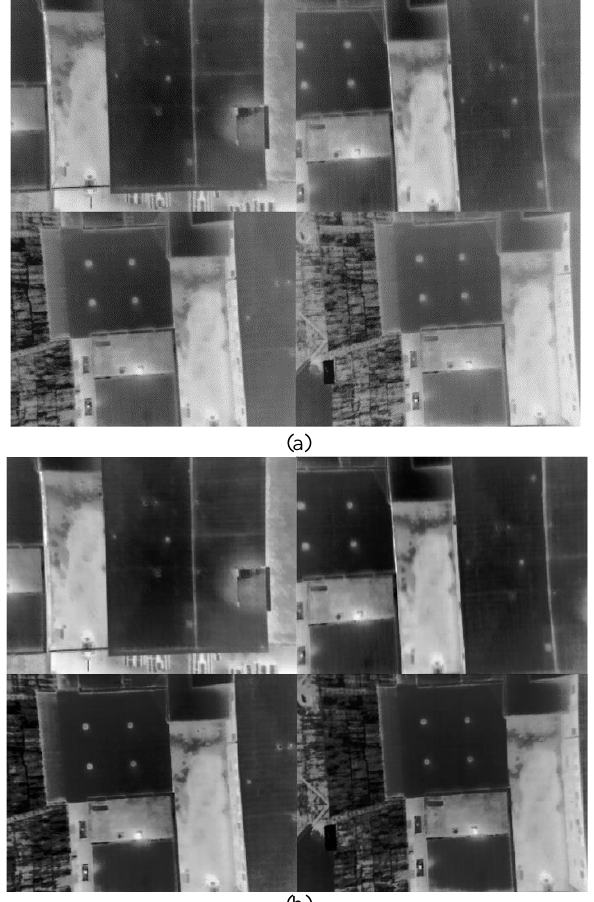
Figure 5: Relative thermographic calibration. First column shows the reference (top), original (middle) and calibrated (bottom) images, while the second column shows the histograms of corresponding images.